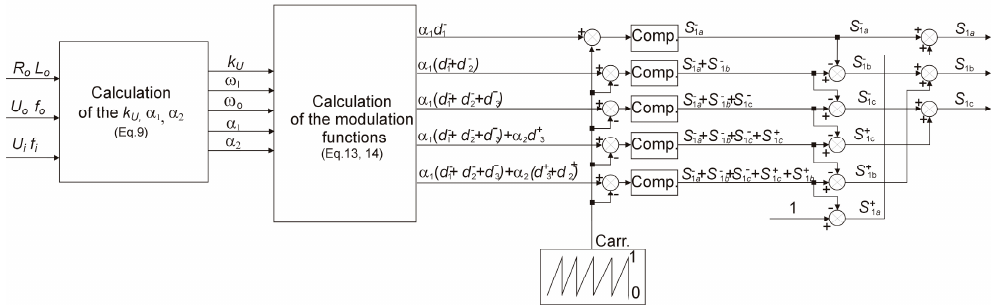
Figure 3. Block diagram of the proposed modulation strategy for output phase number 1.